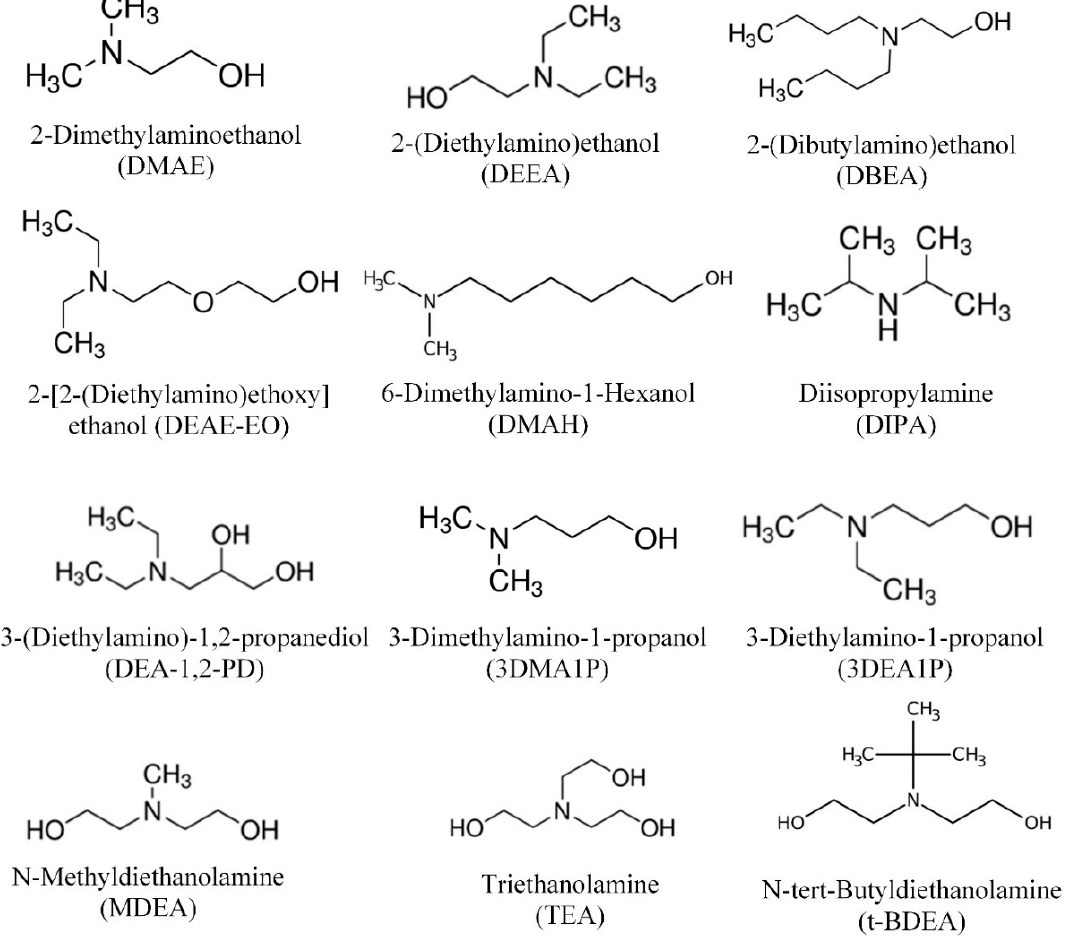
Figure 1. List of amines with chemical structures.